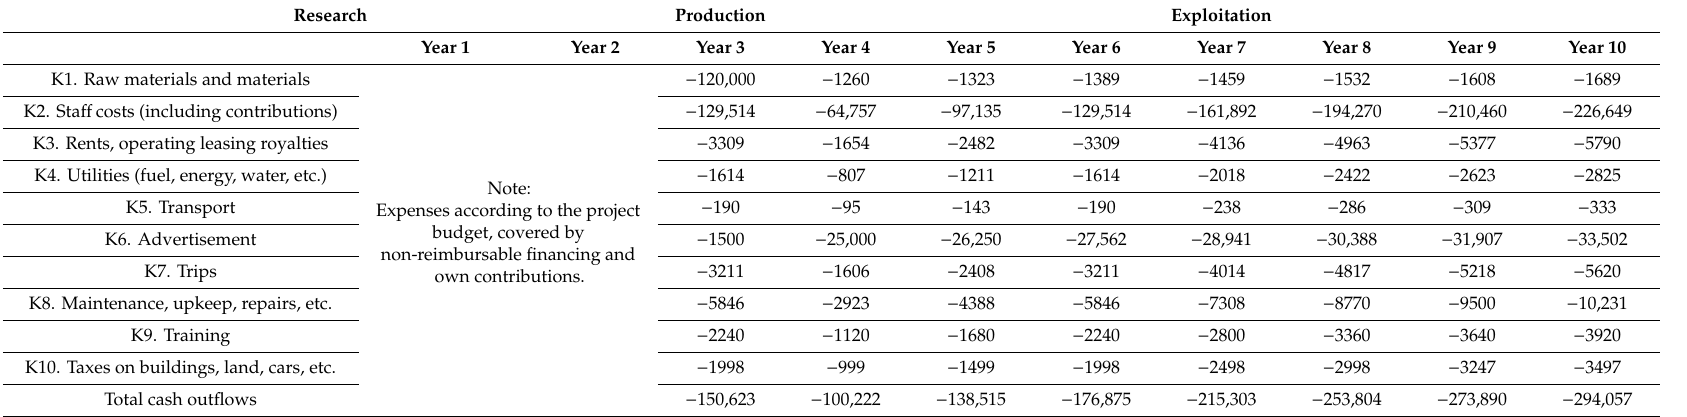
Table 3. Estimation of cost elements.